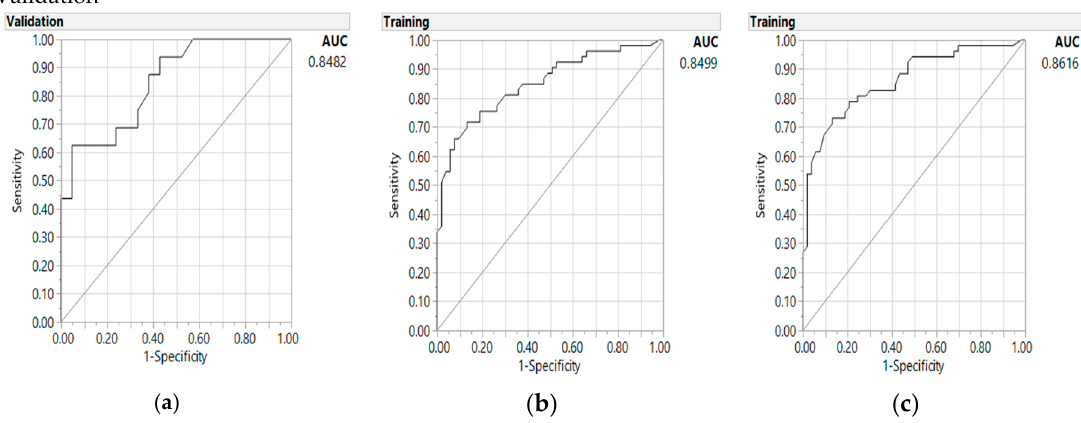
Figure 3. Area under the receiver operating characteristic curve (AUC) for the baseline logistic regression model ( a ), the Elastic Net with Akaike’s information criteria with correction (AICc) validation model ( b ), and the Leave-One-Out validation model ( c ) for the predictors of colorectal cancer with addition of the MTHFR 677 polymorphism and its interaction with overweight status.